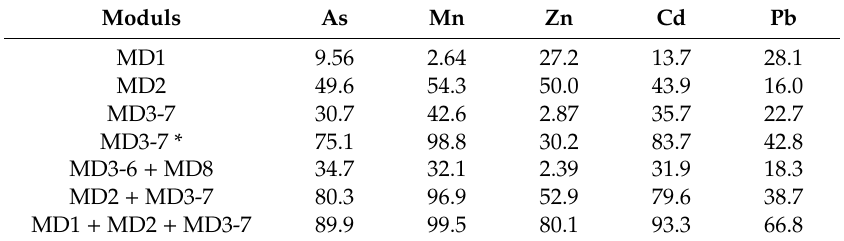
Table 3. Average removal e ffi ciency (%) of As and heavy metals from wastewater in 4 months of